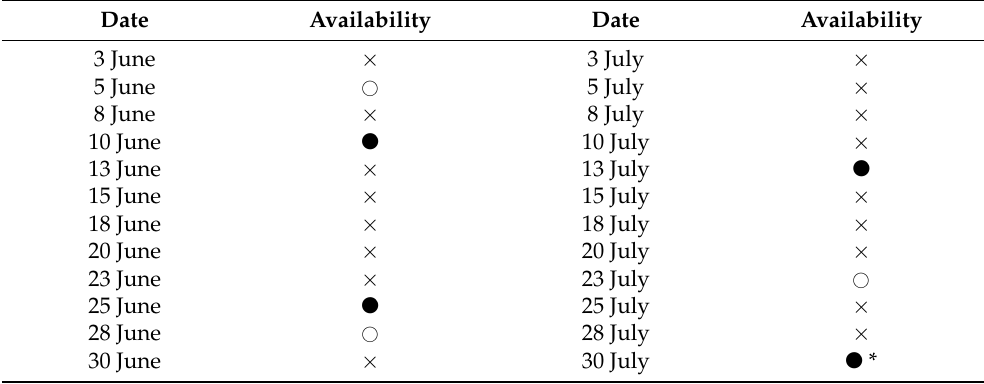
Table 2. List of the availability of cloud-free Sentinel-2 images in the study area from June to July 2019 ( × : cloud-free image unavailable; : cloud-free image available; (cid:108) : cloud-free image used for the experiment; *: target image for virtual image generation).